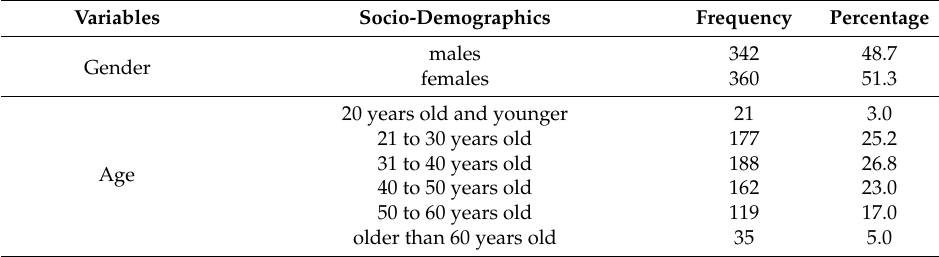
Table 1. Descriptive analysis of socio-demographic characteristics ( N = 702).